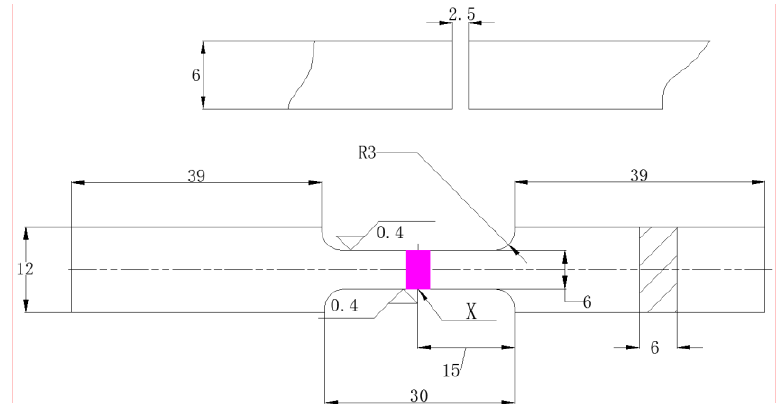
Figure 1. Specimen geometry of welded joint (all dimensions in mm, roughness in micrometers, tolerance for all dimensions ±0.01).